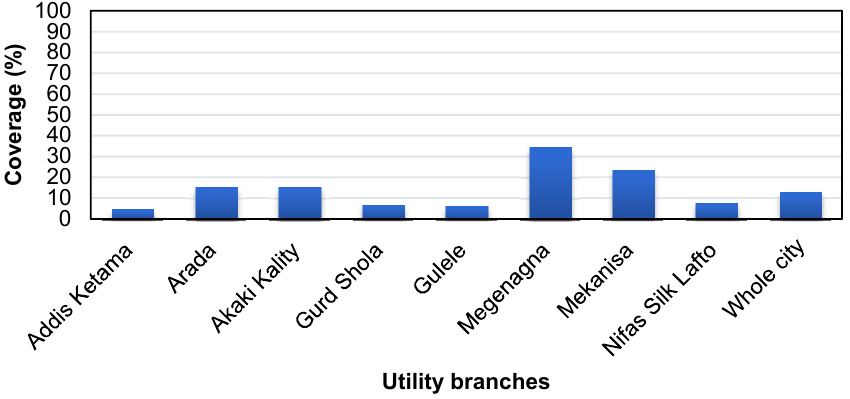
Figure 7. Sewer line coverage of each branch in 2017.